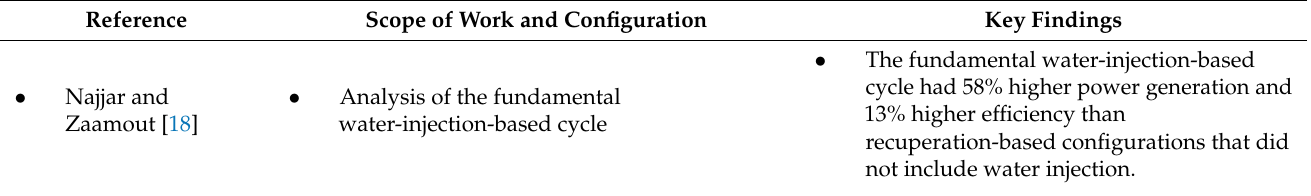
Table 2. A summary of the key efforts in developing gas turbines with recycled water